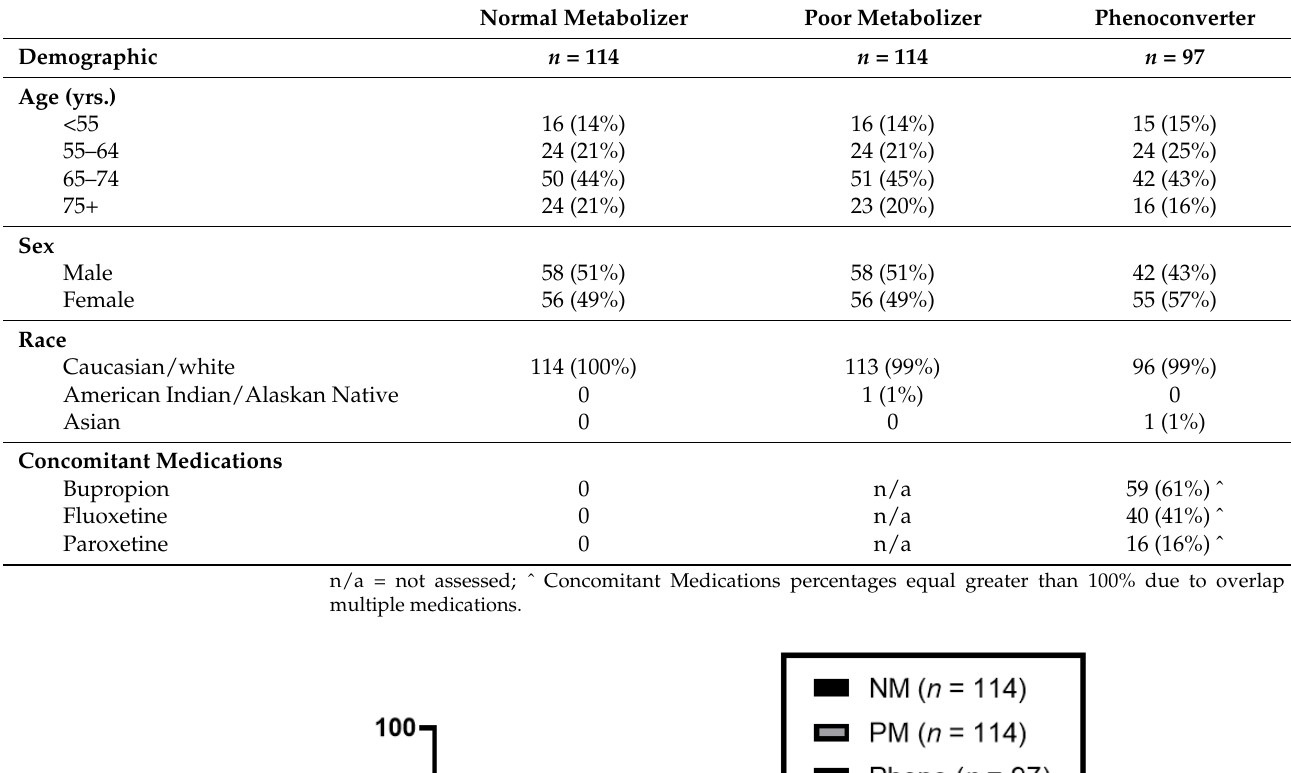
Table 2. Baseline characteristics of the study population.